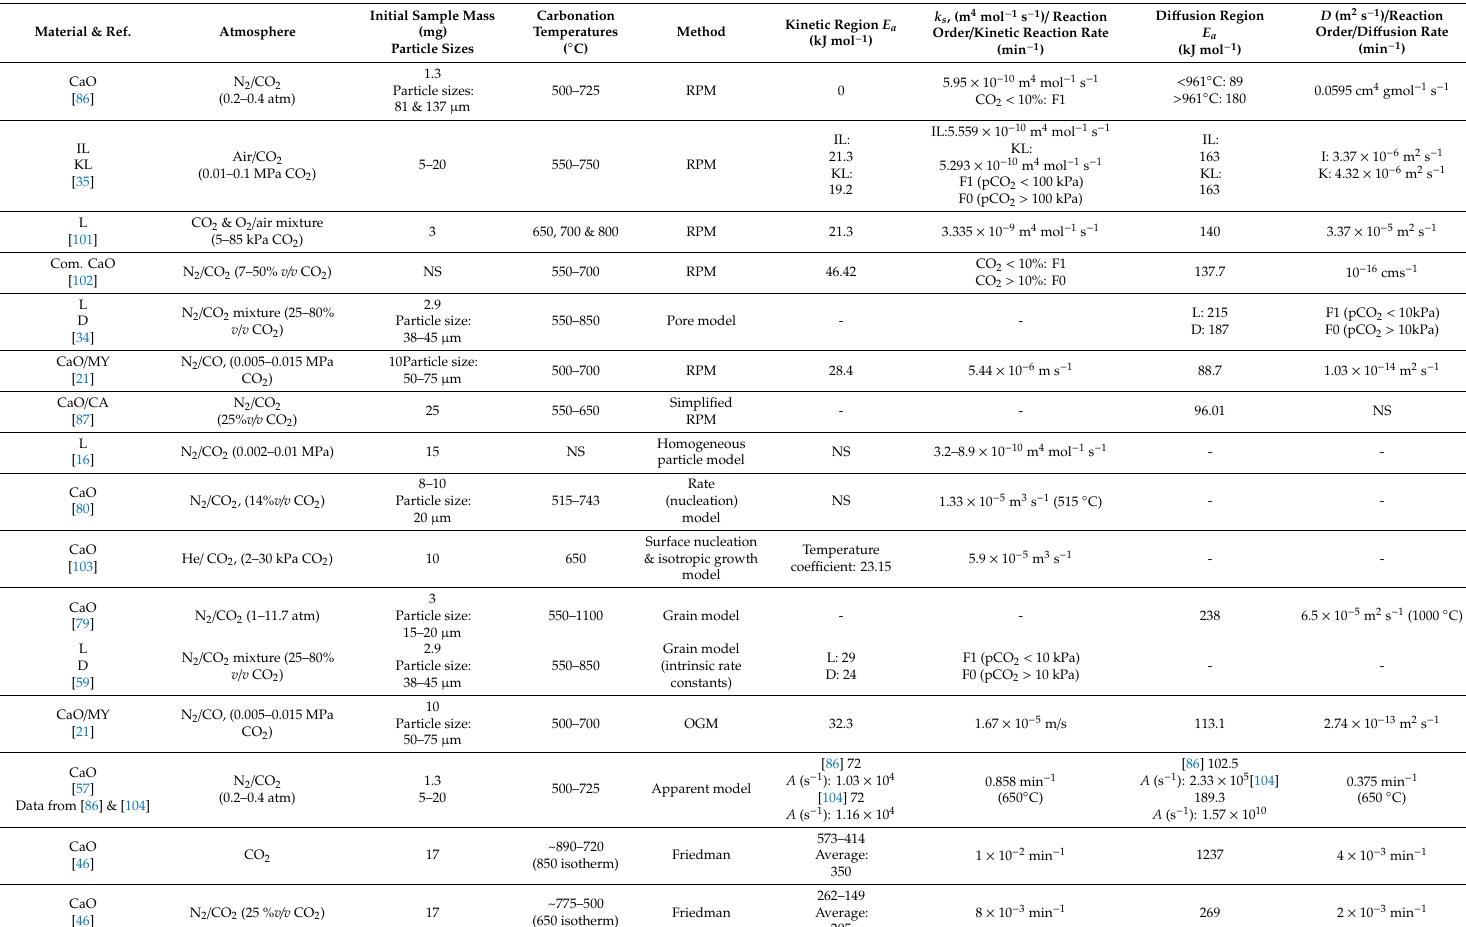
Table 3. Classification of kinetic models for reaction mechanisms. NS = not